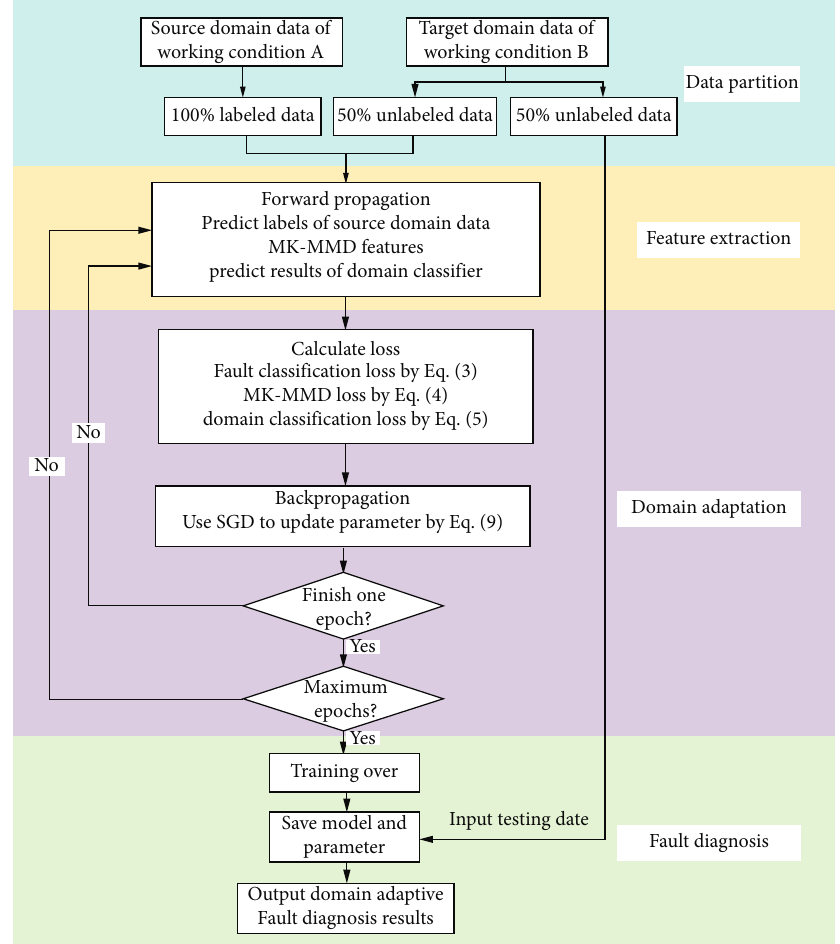
Figure 3: The overall framework of proposed DCDAN.